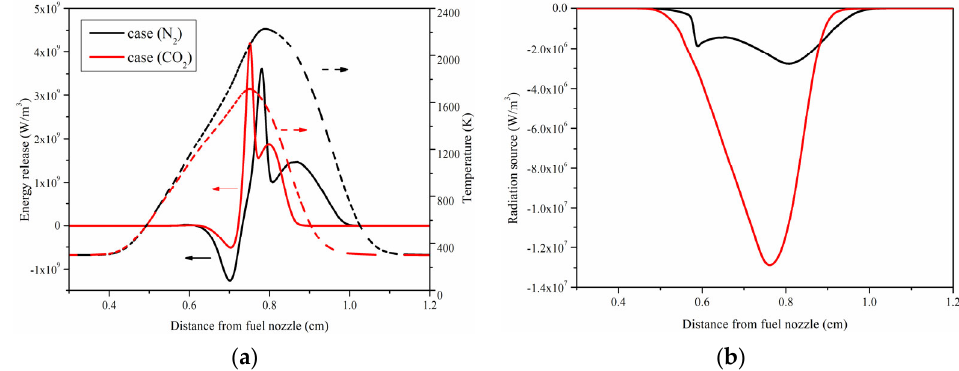
Figure 2. Heat generated by the reaction and temperature distribution ( a ) and radiation source ( b ) in N 2 and CO 2